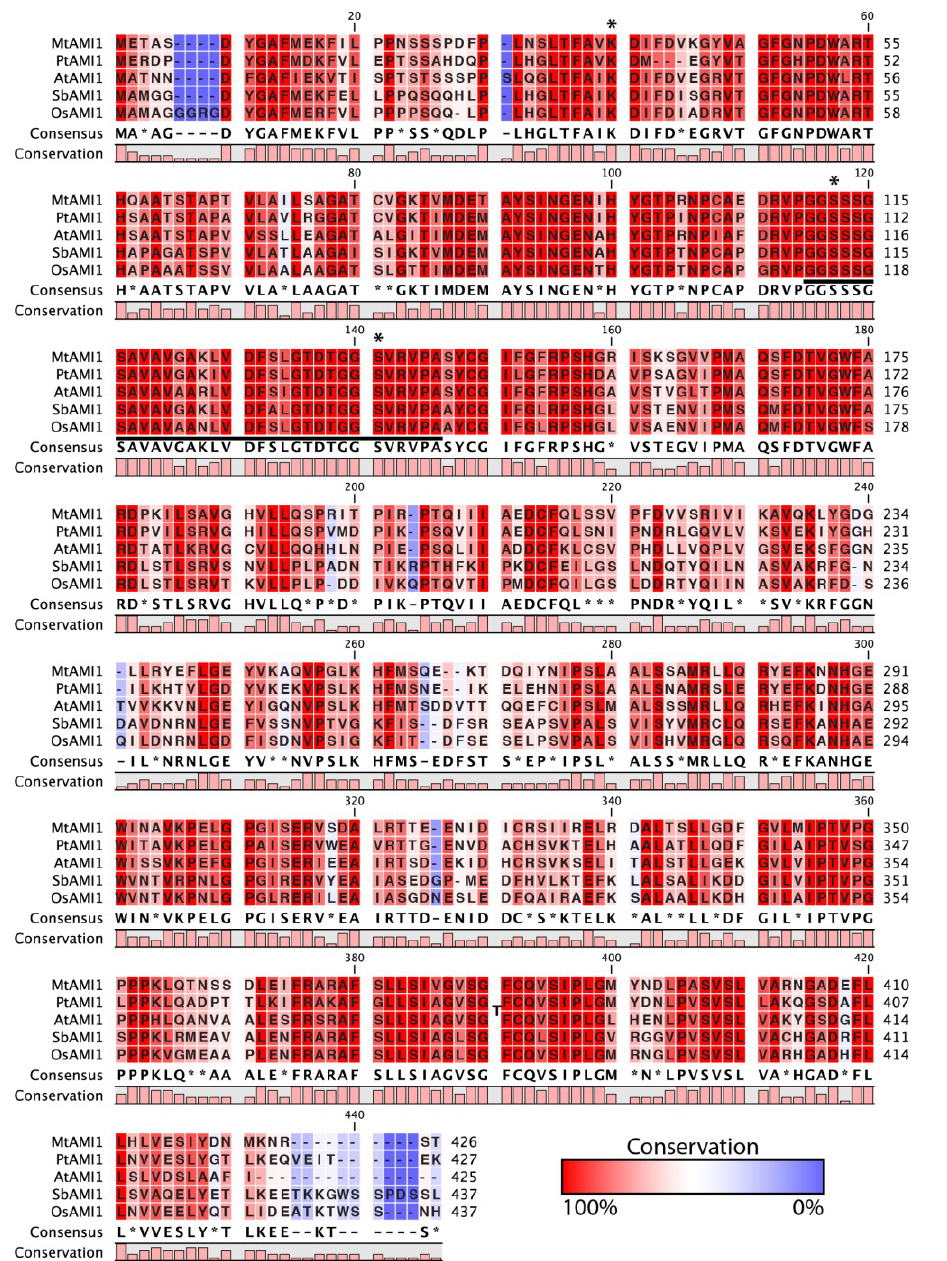
Figure A1. Sequence alignment of five members of the amidase-signature family from plants. The analyzed sequences are At AMI1 (At1g08980), Mt AMI1 (Mt1g099370), Os AMI1 (Os04g02780), Pt AMI1 (Pt13g02200), and Sb AMI1 (Sb02g039510). Amino acid positions are indicated. Sequence conservation among the polypeptides is color-coded in the alignment. Asterisks mark the catalytic triad; the glycine- and serine-rich amidase-signature motif is